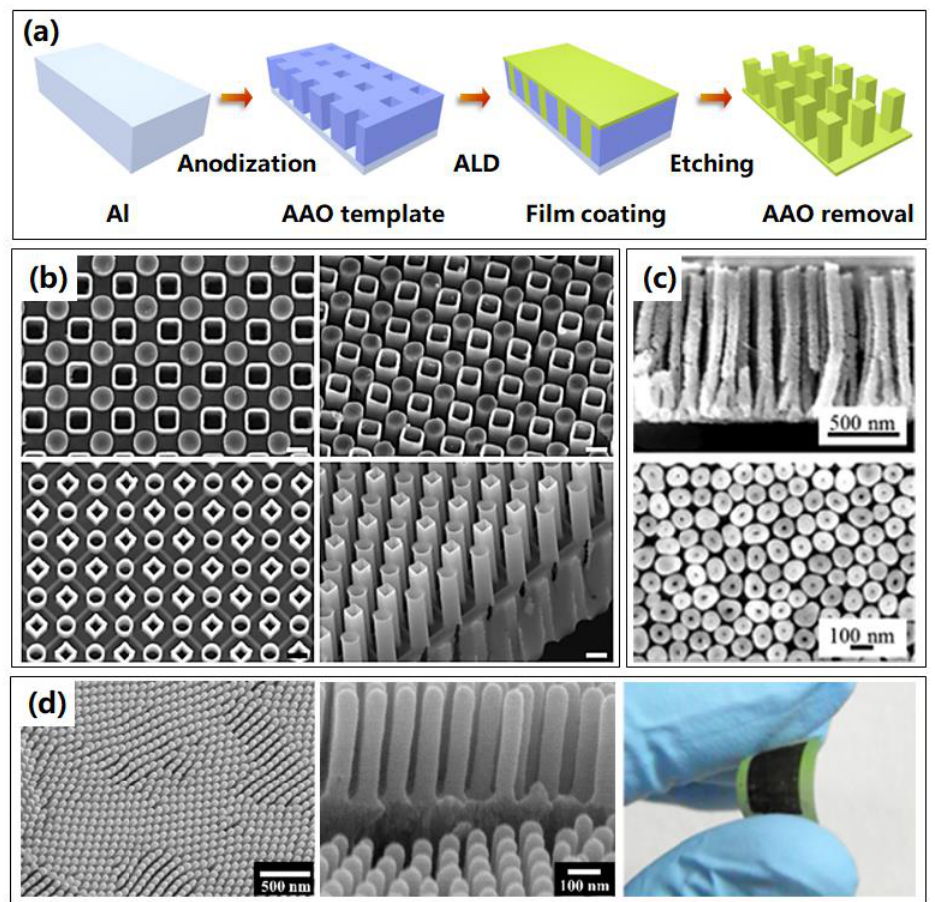
Figure 4. Typical 3D nanostructures fabricated by ALA method through AAO templates. ( a ) Process routine of 3D nanostructures based on AAO templates by ALA method. ( b ) SEM images of representative 3D binary nanostructure arrays. The upper two show nanostructures with nanopillars and nanotubes, and the lower two are nanostructures with all nanotubes. Reprinted with permission from Ref. [40], Copyright 2017 Macmillan Publishers Limited, part of Springer Nature. ( c ) SEM images of 3D ZnO nanowires for sensor applications. Reprinted with permission from Ref. [2], Copyright 2016 American Vacuum Society. ( d ) Overall and enlarged SEM images, and photograph of flexible 3D TiN nanotubes arrays. Reprinted with permission from Ref. [30]. Copyright 2020 MDPI.